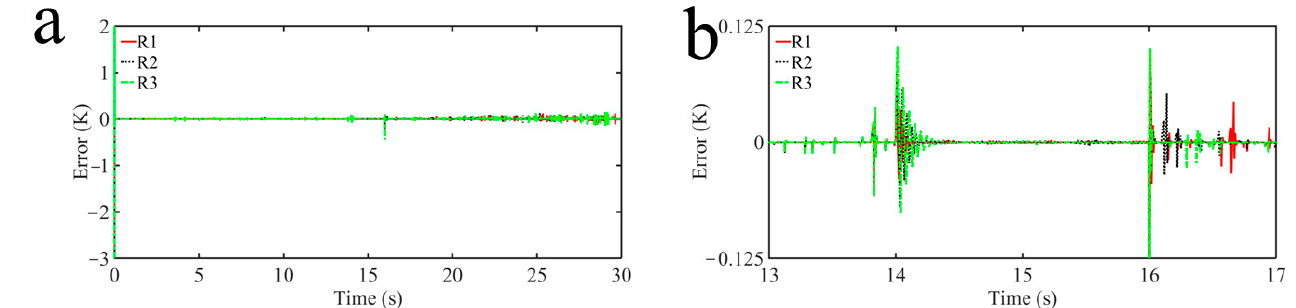
Figure 29. Simulation results with some external disturbances: ( a ) the tracking errors of Wall 1_85 mm for composite controller; ( b ) their partial enlarged figures in details.